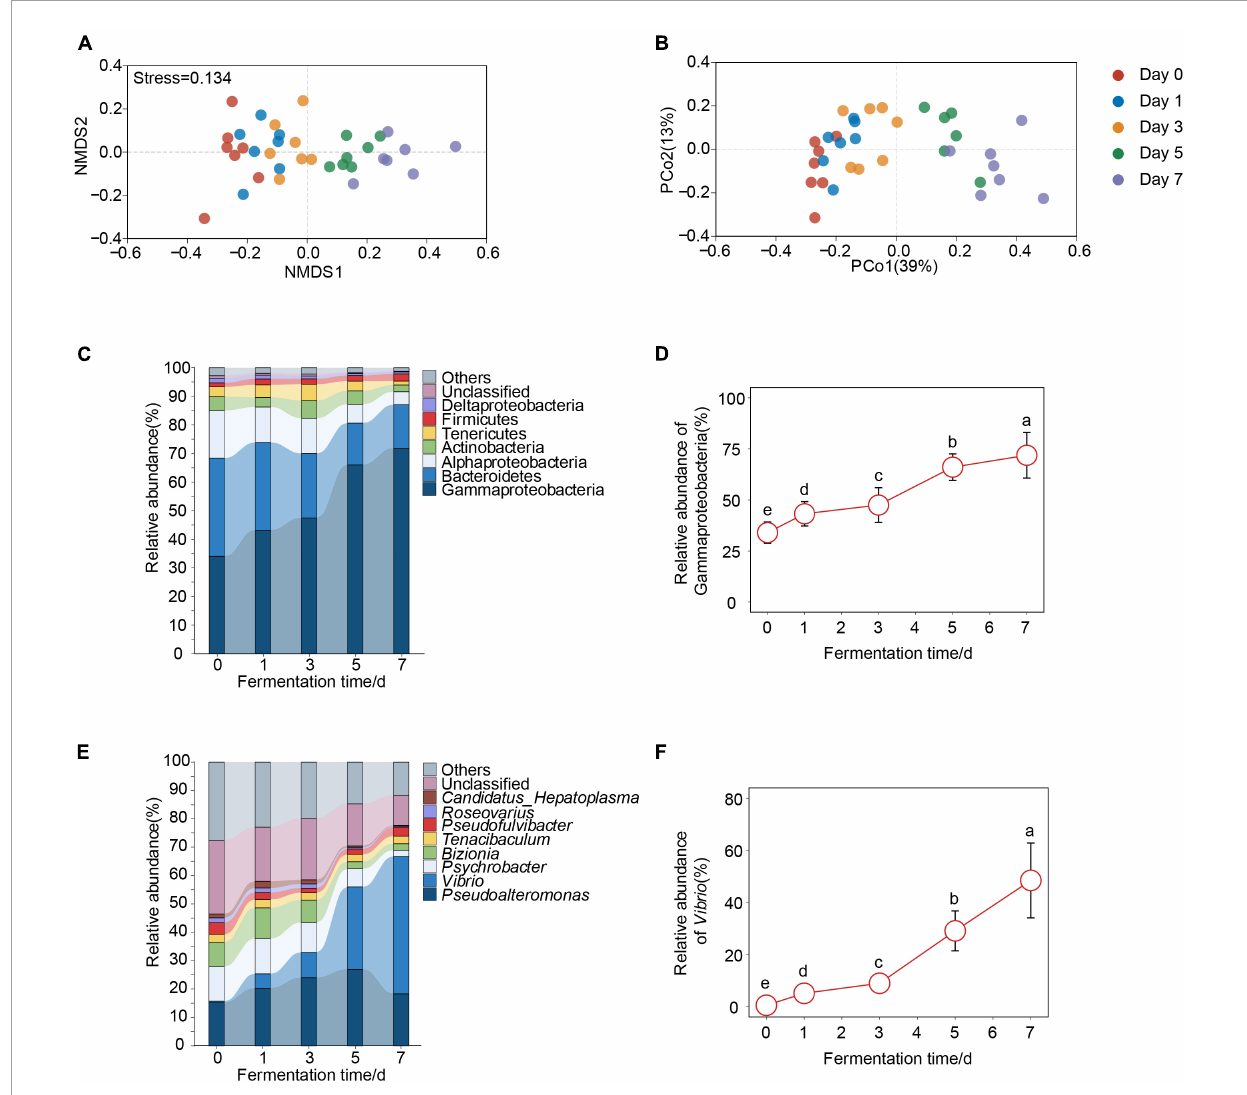
FIGURE2 Changes of bacterial communities over crab paste fermentation. Non-metric multidimensional scaling (NMDS) plot (A) and principal coordinate analysis (PCoA) plot (B) based on Bray-Curtis dissimilarity visualizing compositional variations of bacterial communities of crab paste at day 0 (red), day 1 (blue), day 3 (orange), day 5 (green), and day 7 (purple). The relative abundances of bacterial communities at the phyla/proteobacterial classes (C) and genus (E) Level in crab paste during fermentation. Species with relative abundance < 1% were classified as “others”. Significantly increased phyla/proteobacterial classes (D) and genera (F) over crab paste fermentation. Data present means ± standard deviation. Different letters indicate significant differences among groups ( p <